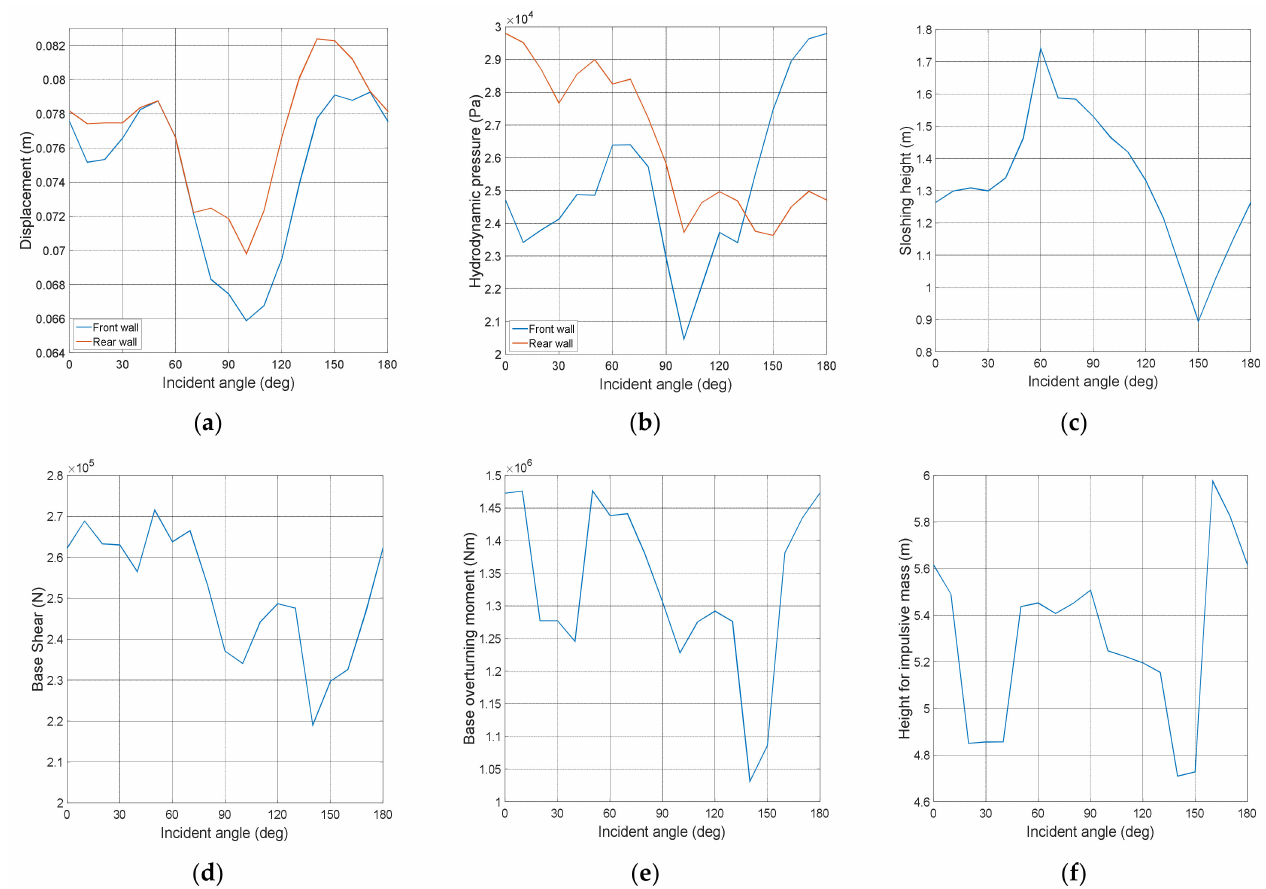
Figure 14. Variations of earthquake responses according to the incident angle of an input ground motion: ( a ) relative displacement; ( b ) hydrodynamic pressure; ( c ) sloshing height; ( d ) base shear; ( e ) base overturning moment; ( f ) height for impulsive